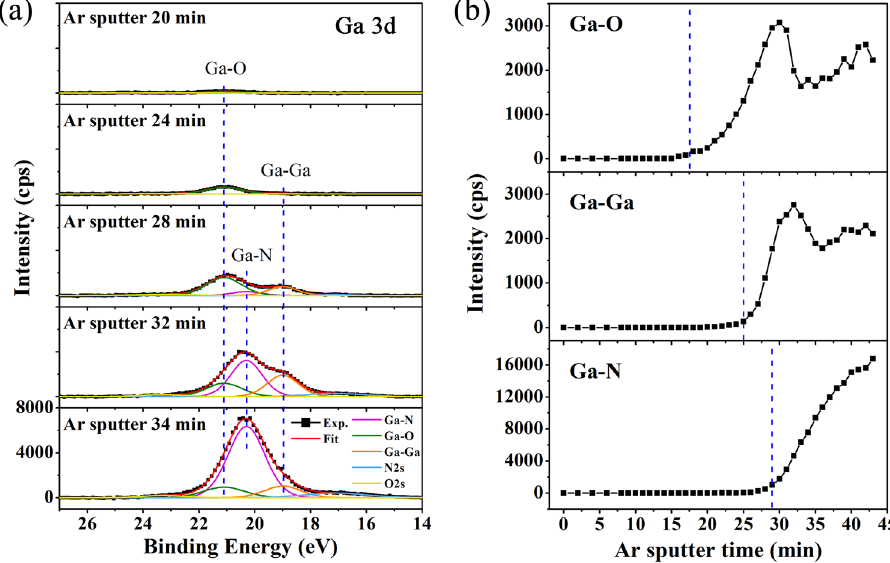
Figure 2. Ion depth profile of Ga element. ( a ) A serial of Ga 3d core level spectra during sputtering with binding energy in the range of 14–27 eV. After subtracting the Shirley background, the Ga 3d peak could be de- convoluted into five peaks. ( b ) Depth profile of different Ga components (Ga-O, Ga-Ga and Ga-N) calcuated from Ga 3d peak as function of sputter